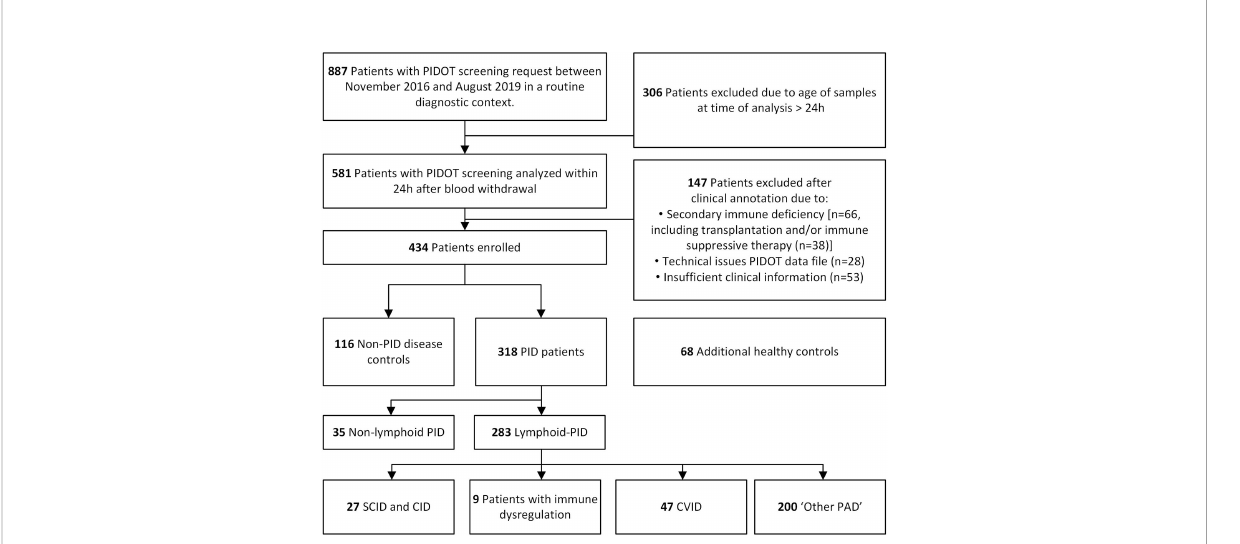
FIGURE 1 Flowchart diagram of study design and population. Blood samples of patients suspected to have primary immunode fi ciency (PID) were analyzed with PID Orientation Tube (PIDOT). After exclusion based on clinical annotation and fl ow cytometric data quality, patients were classi fi ed in lymphoid-PID subgroups [including (severe) combined immunode fi ciencies [(S)CID], immune dysregulation disorders (ID), common variable immunode fi ciency (CVID), and other primary antibody de fi ciencies (PAD), non-PID disease controls, and non-lymphoid-PID